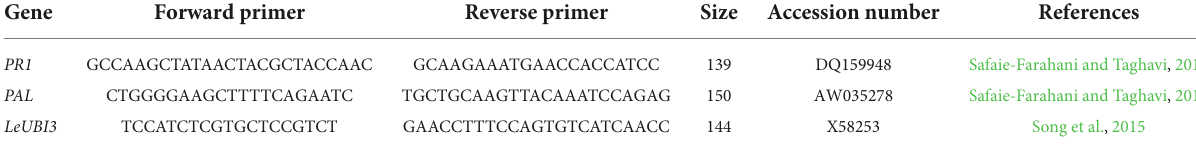
TABLE 1 Forward and reverse